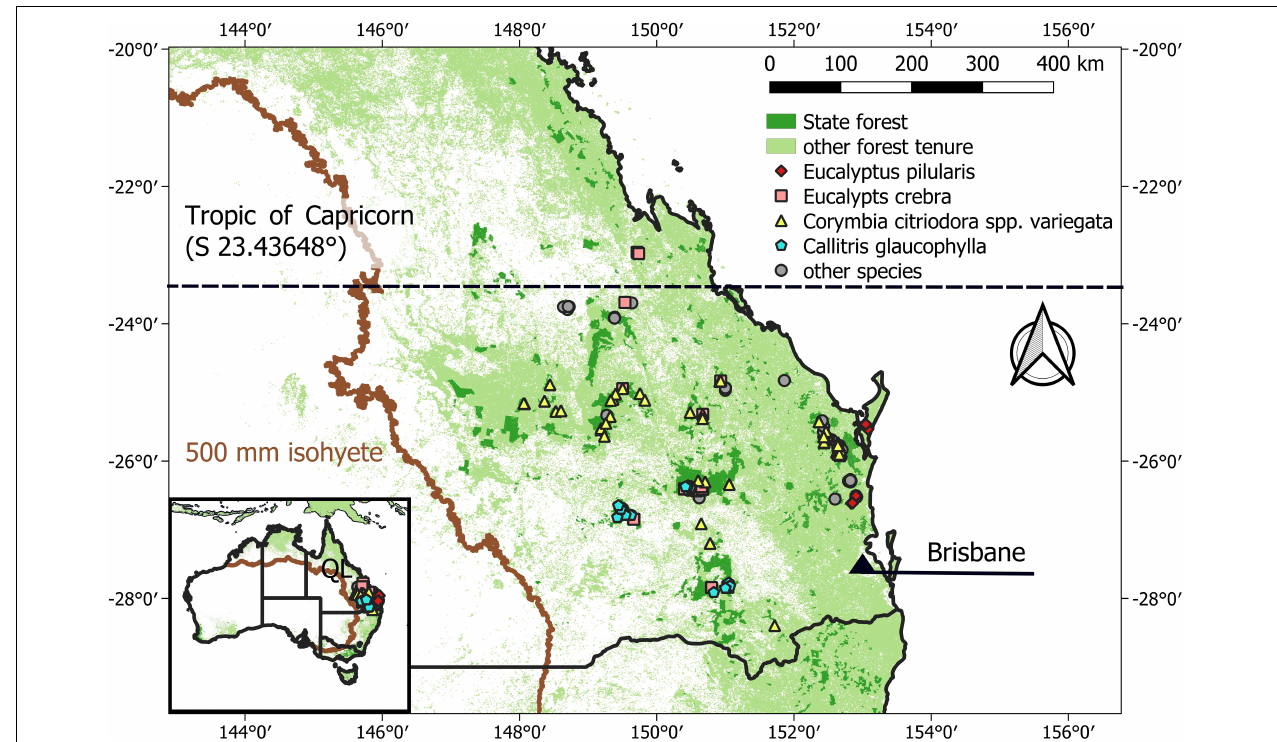
FIGURE 1 | Southern Queensland’s forest cover and forest tenure. Locations of sample plots used in this study are marked. Forest cover includes forest and savanah classified by MODIS landcover (Friedl et al., 2010). The four most frequent dominant tree species ( Table 1 ) are identified by colors and shapes. Overlapping plot locations explain discrepancies to plot numbers shown in Table 1 . We marked the Tropic of Capricorn, dividing the Subtropics from the Tropics. We also show the 500 mm isohyet—a common threshold used in Australia for delineating semi-arid ecosystems. The data source is WorldClim data representing annual average precipitation sum in 1970–2000 (Fick and Hijmans,